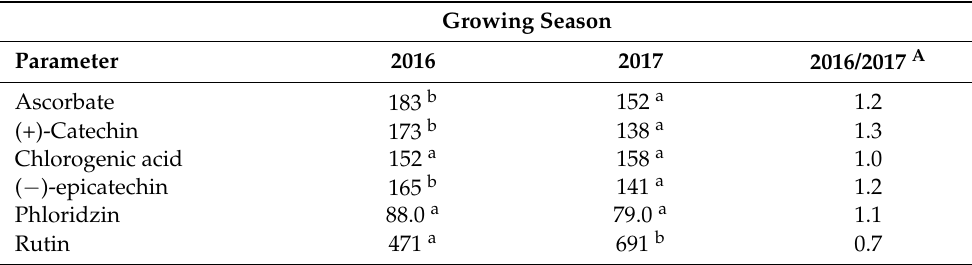
Table 6. The influence of the growing season on the concentrations of biologically active